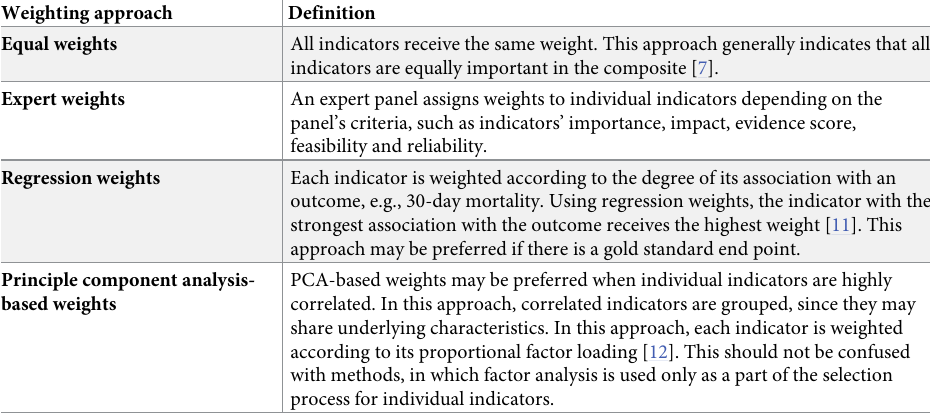
Table 2. Examples of weighting approaches for constructing composite